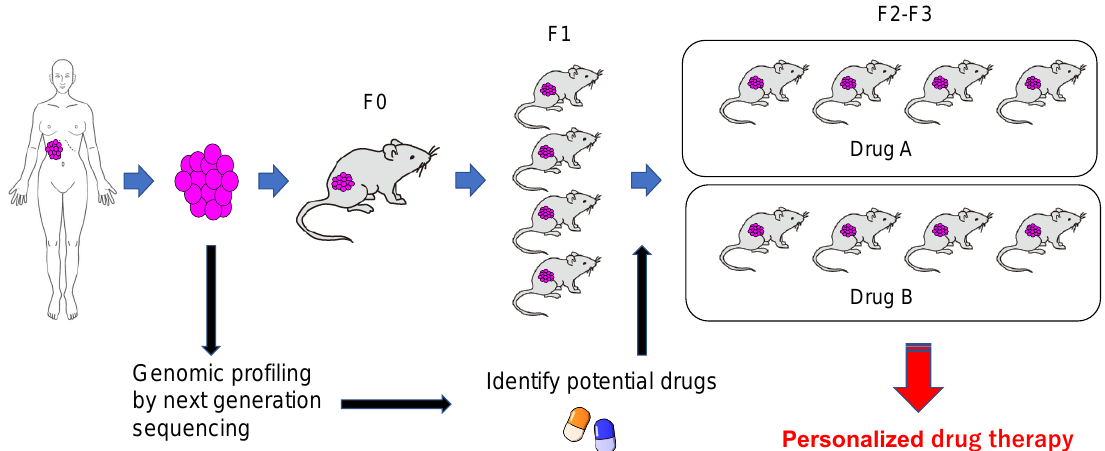
Figure 3. Grafting of patient-derived tumor cells into intensely immunodeficient mice leads to tumor growth within several months. The expanded tumor is excised. Part of the tumor is frozen, and the other part is again grafted into intensely immunodeficient mice. Multiple candidate drugs are selected corresponding to the genetic profile of a given tumor, and each drug is administered to the PDX mice to evaluate its efficacy. If drug sensitivity data collected using these are utilized for patients, then precision cancer medicine may become possible.